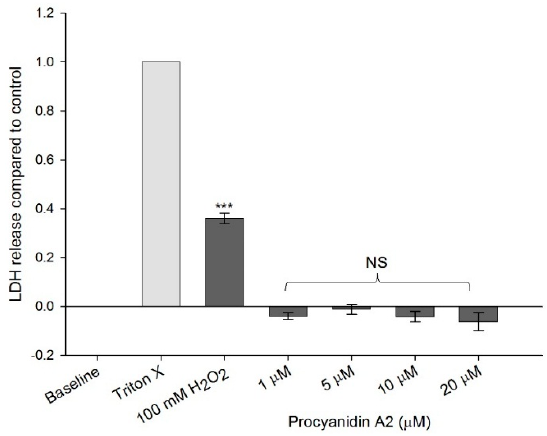
Figure 3. Effect of procyanidin A2 on cell viability, from lactate dehydrogenase assay. A549 cells were seeded at 9 × 10 5 in 6-well plates, serum starved for 24 h and incubated with procyanidin A2 from 1 to 20 μ M, control media, or positive control 100 mM H 2 O 2 for 6 h. Supernatants were collected and assayed for lactate dehydrogenase (LDH). Results are expressed relative to baseline (0% cell death) and Triton X-100 (100% cell death). The results are expressed as mean ± SEM, which were from 3 separate experiments and 9 individual measurements. NS = not significant, *** p < 0.001.